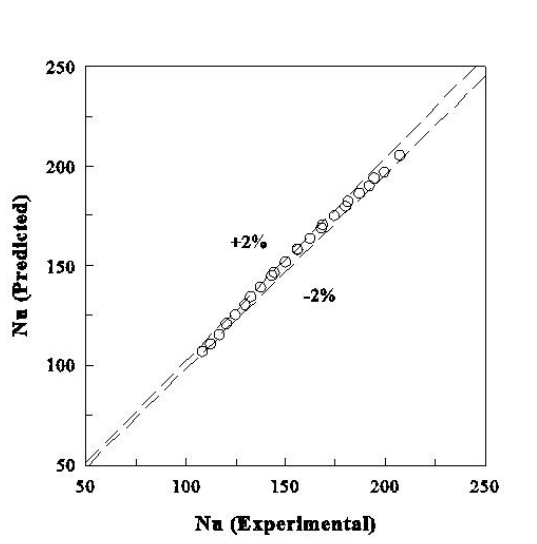
Figure 10: Comparison between predicted and experimental Nusselt